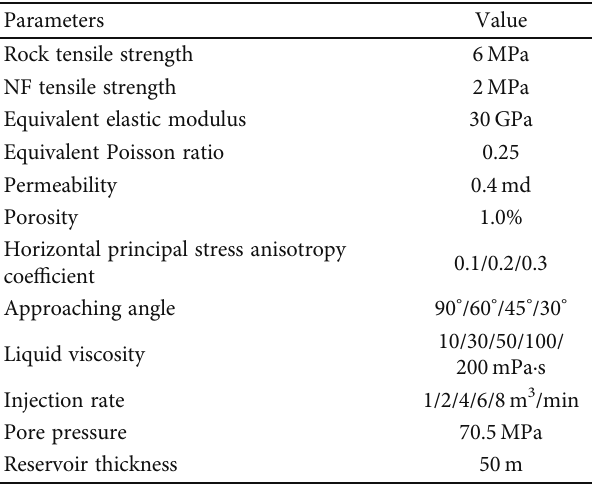
Figure 7: Breakdown pressure (a), fracture length (b), and fracture opening (c) in Cases 1, 2, 3, and 4. Table 1: Input parameters of FE